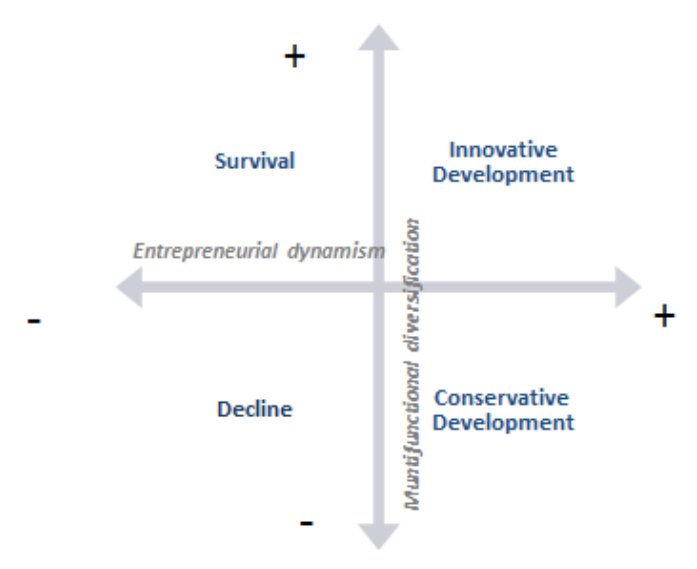
Figure 1 . The definition of farming styles according to the level of multifunctional diversification, and entrepreneurial